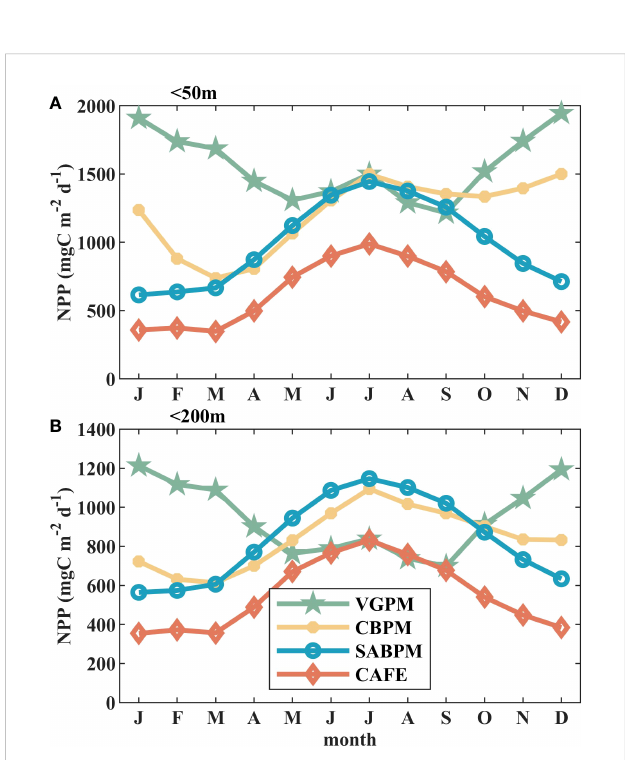
FIGURE 2 Monthly average variations of mean NPP calculated by the four algorithms in nearshore water: (A) less than 50 m and (B) less than 200